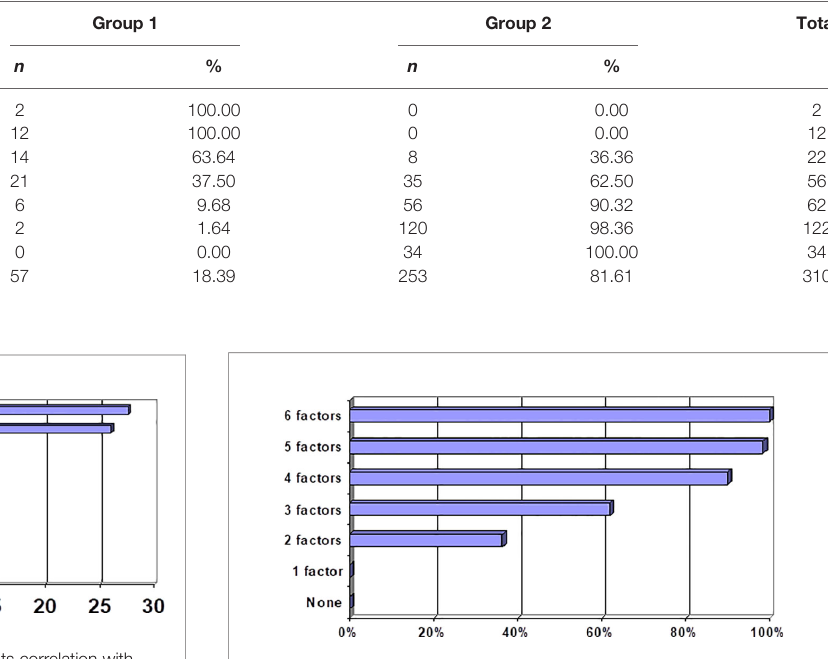
FIGURE 1 | Incremental CS-associated risk (OR) and its correlation with unfavorable lab test values. FIGURE 2 | CS incidence rate in correlation with different sets of risk